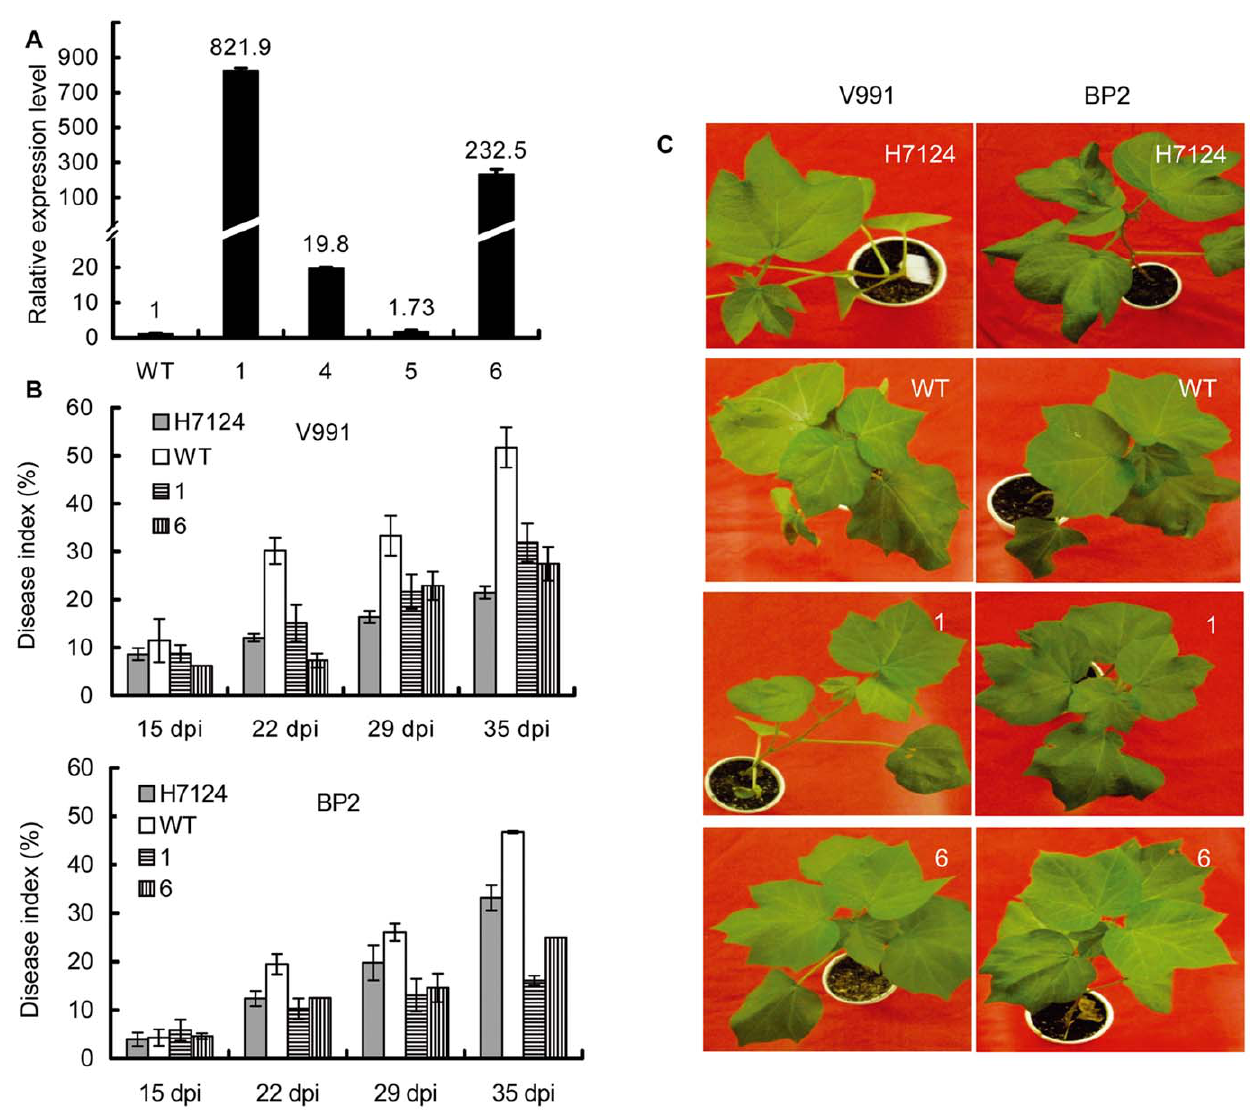
Figure 6. Gbve1 confers Verticillium wilt resistance in transgenic upland cotton. (A). Relative expression level of Gbve1 genes in T 1 transgenic cotton lines. (B). The disease indices of T1 transgenic cottons with infection by V. dahliae defoliating isolate V991 (upper panel) and non- defoliating isolate BP2 (down panel). Results were presented as means 6 SE from three replications with at least 10 plants per replication. (C). The phenotypes of transgenic cotton lines with infection by V. dahliae isolates. Figure S2 Phenotypes of gene silenced lines of Gossy- pium barbadense . WT: without agroinfection treatment, CLCrV-A-vdr2 + CLCrV-B: agroinfection with vector CLCrV-